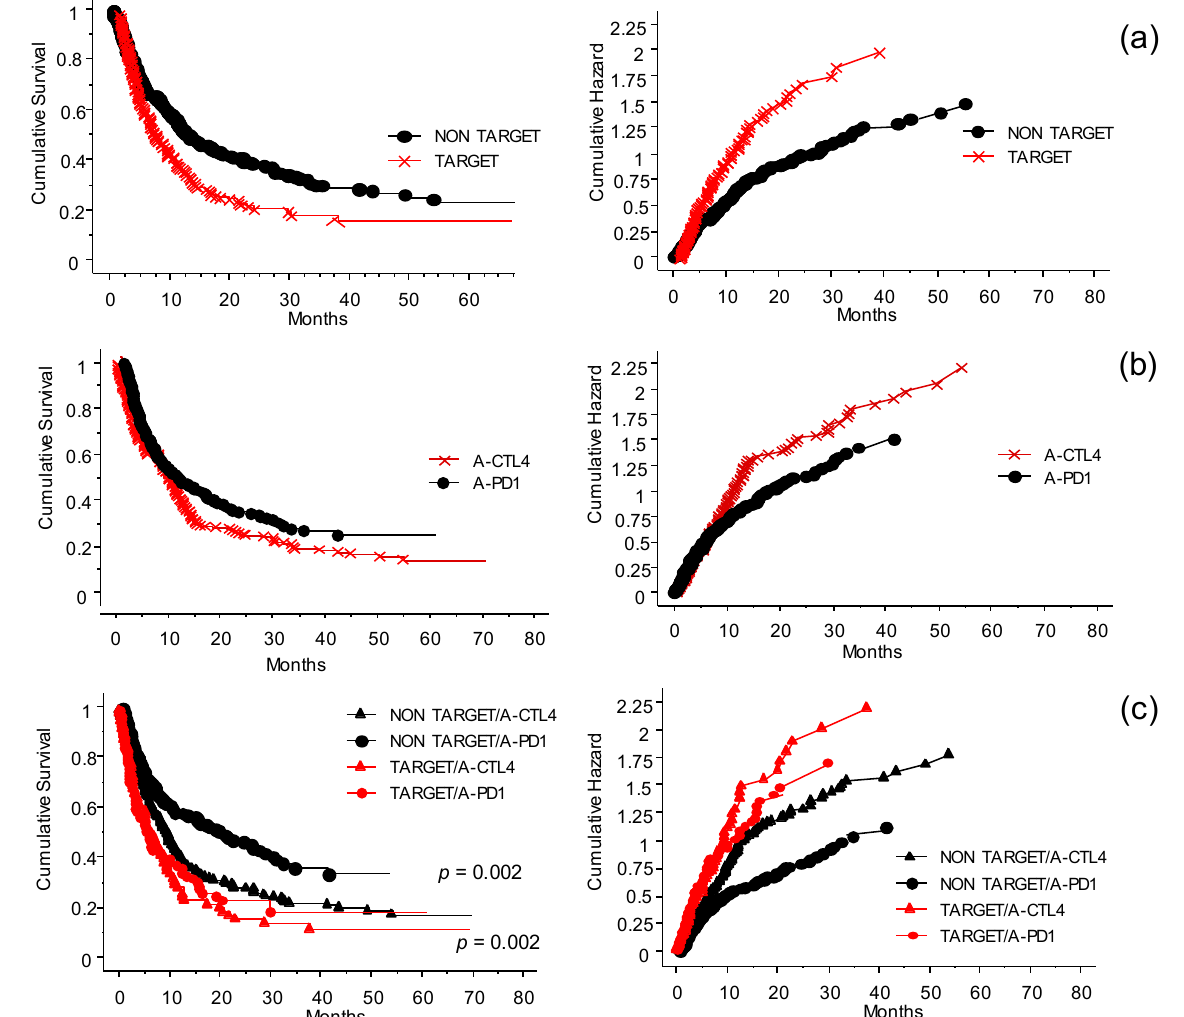
Figure 4. Interaction and significance of the treatments received before inclusion in the ICI program at the INT-NA: cumulative survival (left panels) and hazard plots (right panels). ( a ) The treatments before inclusion (see Figure 2b) have been simplified by grouping them into target (red line) or non-target (black line) groups. Patients who did not receive target treatment had more favorable outcomes ( p < 0.0001). ( b ) In the cohort of patients who received prior TT, when exposed to anti-CTLA-4 ( × ) or anti-PD-1 ( • ) (i.e., naïve not included), interestingly, the effect of anti-PD-1 was not significantly different from that of anti-CTLA-4 ( p = 0.07). ( c ) Significance of first-line treatment with target or non-target therapy on the outcome of the ICI program. In both anti-CTLA-4 ( ∆ ) and anti-PD1 ( • ) treatments, patients who did not receive previous target treatment had a more favorable outcome ( p = 0.002).